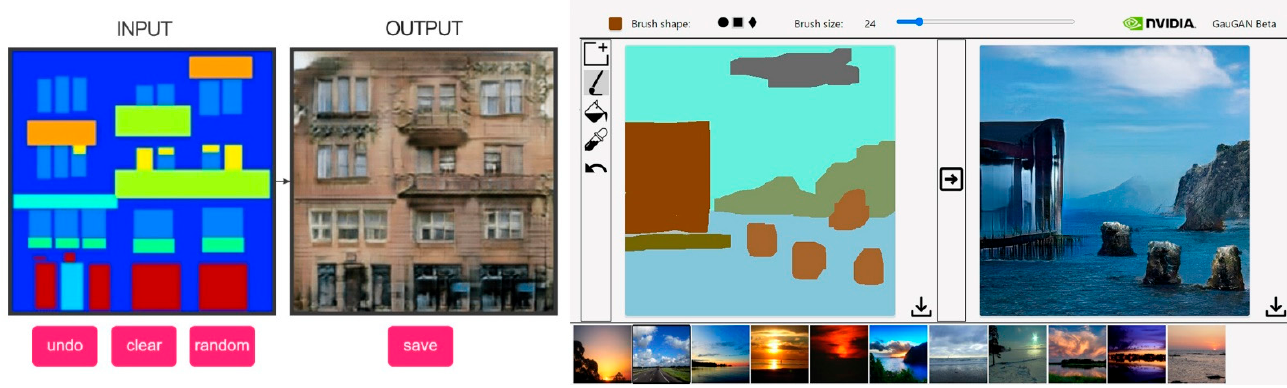
Figure 2. pix2pix ( left ) and Nvidia’s GauGAN ( right ). Screenshot showing the direct conversion from input and output.